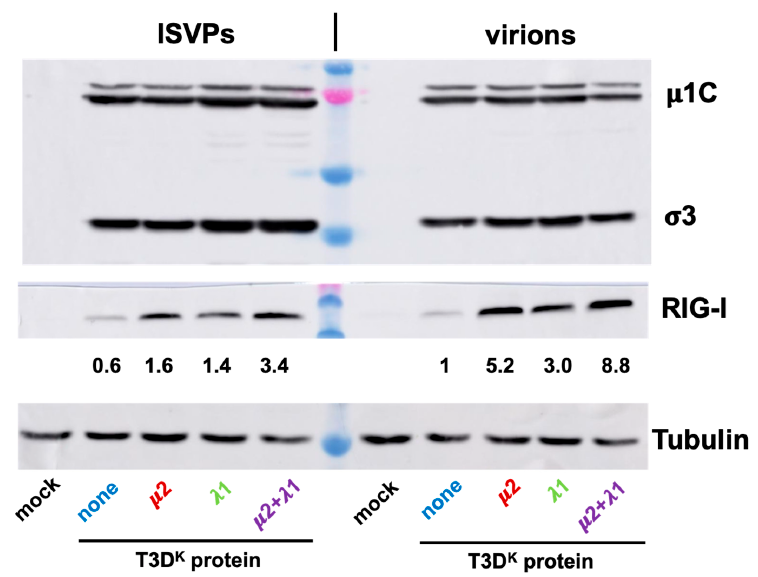
Figure 8. Comparison of virions and ISVPs. Infectious virus stocks were prepared and treated with chymotrypsin as in Figure 7, and used to infect L929 cells. Proteins were recovered and analyzed for viral proteins, RIG-I and tubulin, as indicated. Relative RIG-I values were calculated taking into account small differences in tubulin and levels of viral proteins, the value for T3D S virions being fixed as